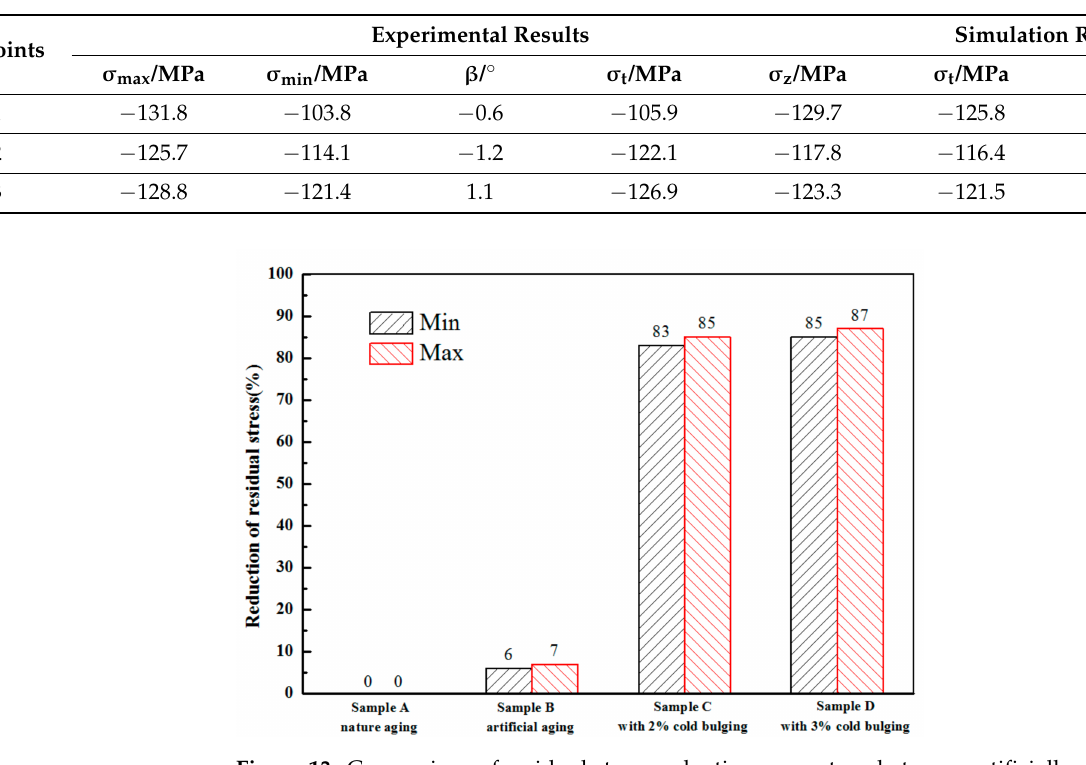
Figure 12. Residual stresses magnitudes as measured via the hole drilling strain-gauge method. Table 4. Experimental and simulation results of quenching residual stress of taper cylinder forging.